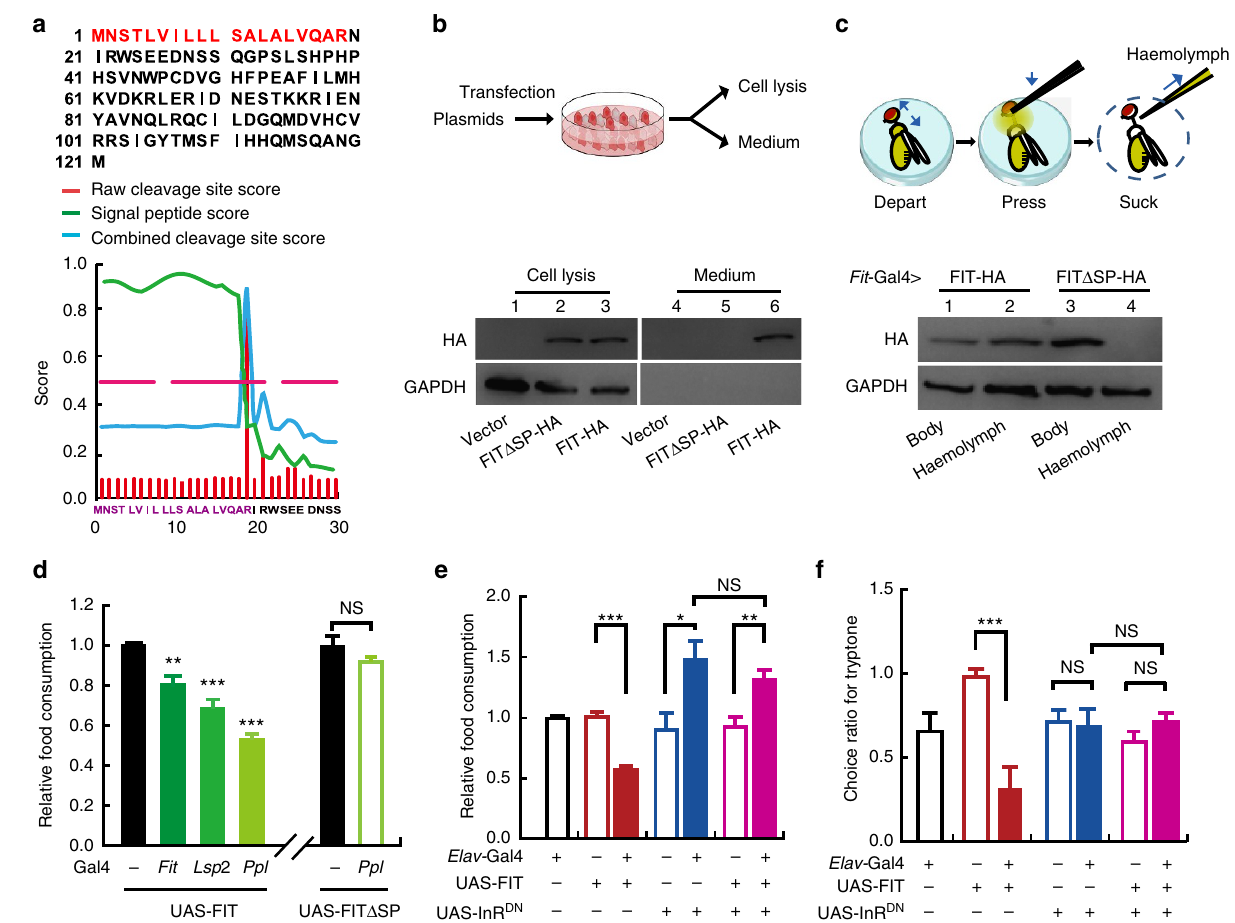
Figure 5 | FIT is a secreted peptide and exerts its feeding suppression function by interacting with the insulin signalling in the nervous system. ( a ) The first 19 AAs (red) of FITwere predicted to be a SP according to the three output scores produced by the neural networks software in SignalP 4.1. ( b , c ) HA signal was detected in conditioned medium ( b ) and fly haemolymph ( c ) of FIT-HA groups, but not FIT D SP-HA control groups. As control, HA signal was detected in cell lysis ( b ) and whole-body lysis ( c ) of both expression groups. The western blot experiments were replicated three times. ( d ) FB-expression of FIT, but not FIT D SP, suppressed feeding behaviour. n ¼ 8–16. ( e ) Flies co-expressing FIT and InR DN in the nervous system exhibited over-feeding behaviour similar to InR DN -overexpressing flies. n ¼ 6–8. ( f ) Overexpression of FIT significantly suppressed the CR for tryptone, while this effect was abolished when InR DN was co-expressed with FIT. Tryptone and sucrose were used in the two-choice assay. n ¼ 5–12. Data are analysed